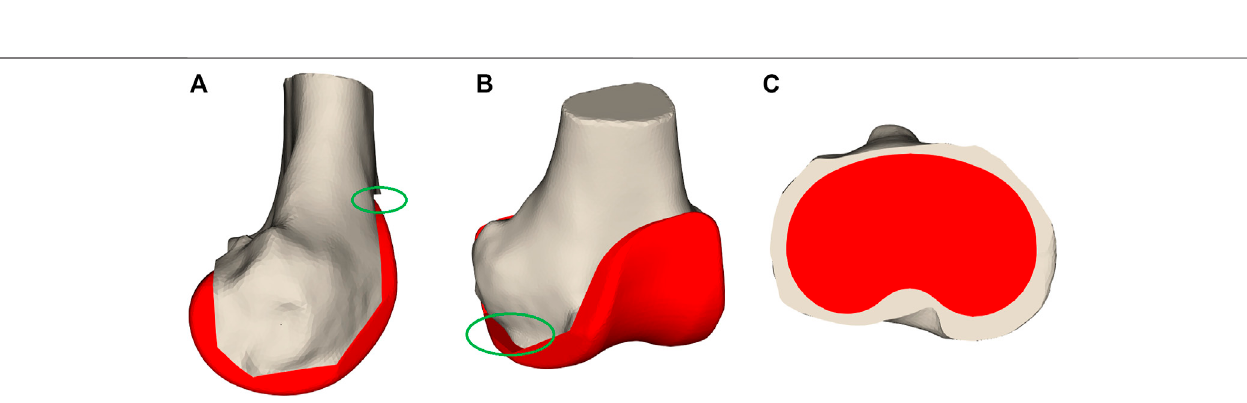
FIGURE4| Bonemeasurements.Panel (A) displays notchingwhere thefemoralimplant istoomuch rotatedinanextendedorientationthatitundercutsthebones as visualized in the green oval. In (B), the femoral implant overhangs on the medial side indicated by the green oval. Panel (C) demonstrates tibial implant underhang where a large part of the tibial plateau is not covered by the implant